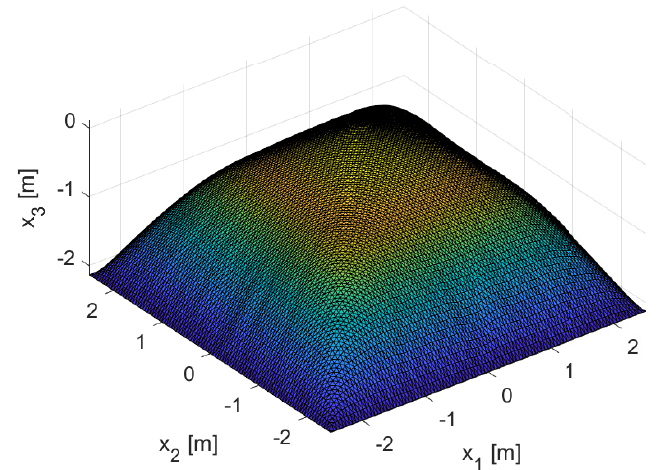
Figure 9. Best fitting membrane shape after the first optimization phase, for the problem of the cloister vault.